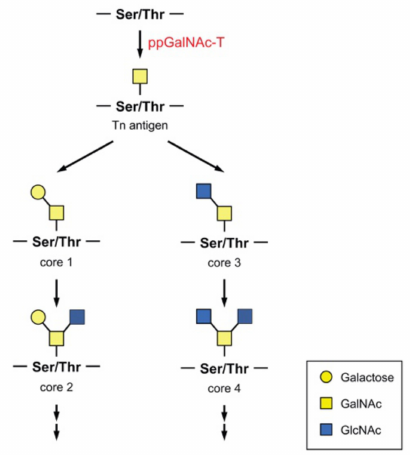
Figure 2. Core structures of O -GalNAc